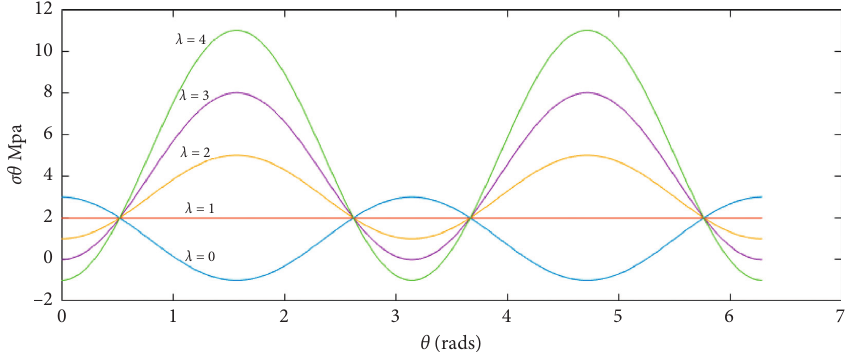
Figure 3: σ stress distribution of the surrounding rock when λ � 0 ∼ 4, θ � 0 ∼ 2 π , and R � r . θ